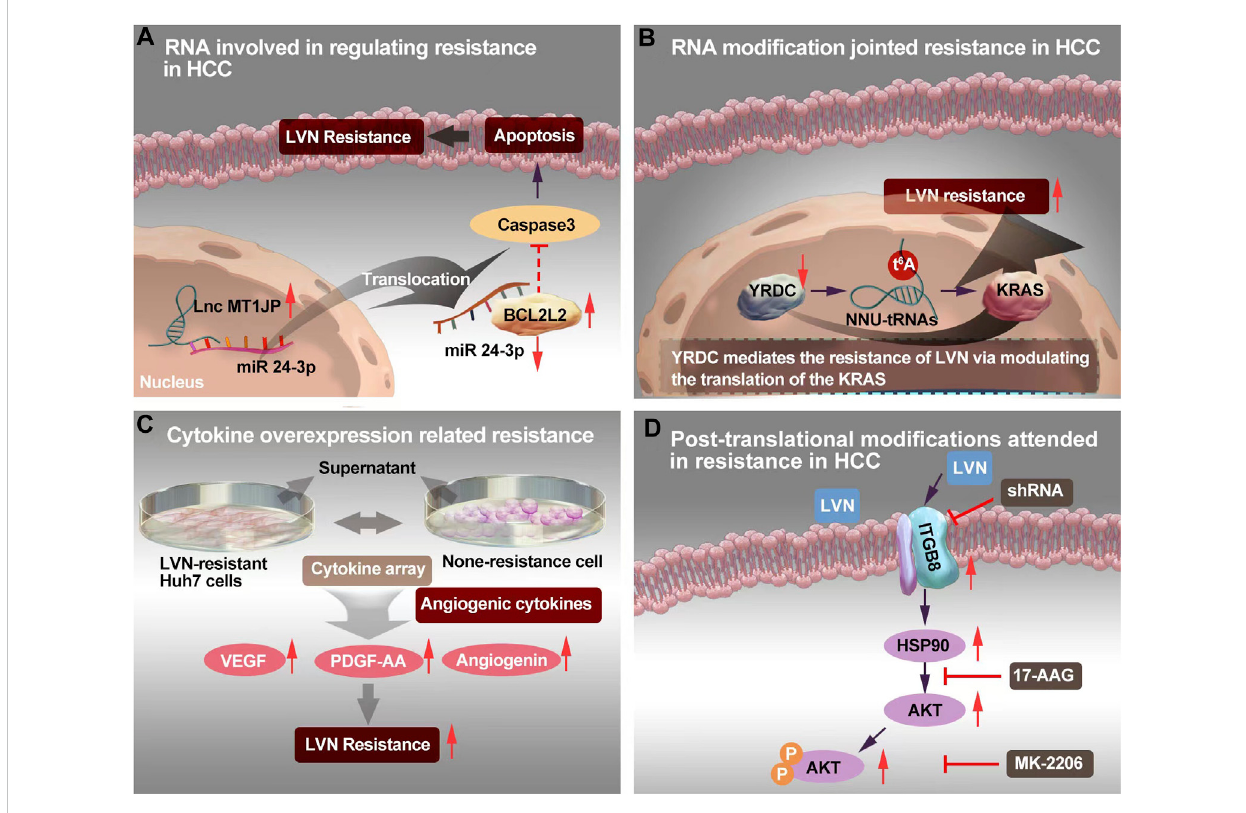
FIGURE 3 The resistance mechanism focuing on RNA, RNA modi fi cation, cytokine and post-translational modi fi cation of LVN. (A) Sponging of microRNA-24- 3pbyMT1JPreleasedBCL2L2,therebyforming apositive-feedbacklooptorealizeLVNresistance. (B) YRDCknockdownshoweddecreasedsensiticityto LVN via t6A modi fi cation. (C) Angiogenic cytokine overproduction confered in LVN-resistance in HCC and thereby contribute to tumor angiogenesis to increase the occurence of resistance. (D) Up-regulated ITGB8 in LVN resistance HCC cells leading to AKT ’ s ubiquitination to achieve